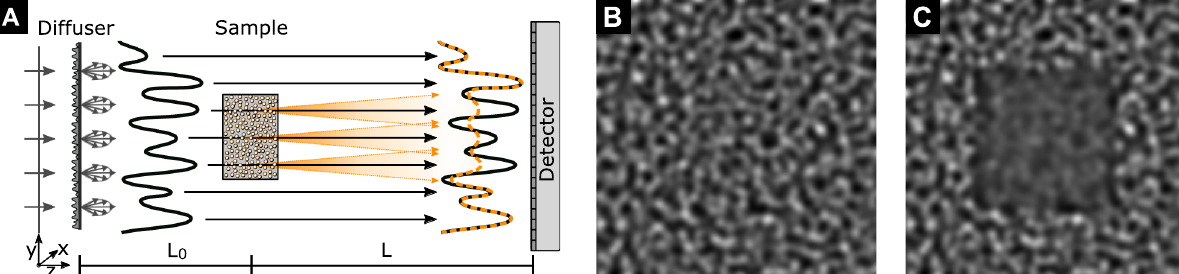
Figure 1. Principle of speckle-based dark-field imaging. ( A ) Coherent X-rays impinge on the diffuser, are randomly scattered, and mutually interfere with the incident beam to create a random intensity (speckle) pattern (black solid line), which does not change upon propagation within the near-field regime. Diffuse small-angle X-ray scattering from the sample microstructure causes a measurable visibility reduction of the original speckle pattern (orange dashed line), which corresponds to the dark-field signal. In this illustration, beam divergence, transmission and phase-contrast effects are neglected. Drawing is not to scale. ( B ) Simulated speckle pattern in the detector plane for a setup without sample and ( C ) for a cube filled with micro-spheres, resulting in a reduction of the speckle